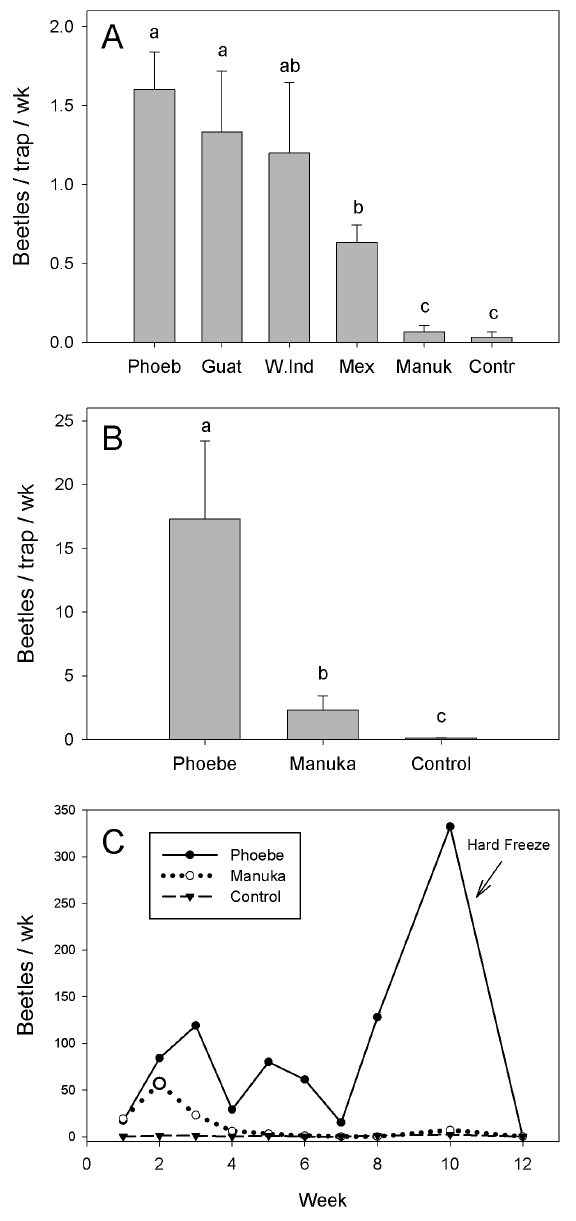
Figure 1: Captures of female Xyleborus glabratus in field trials conducted in Florida, USA. ( A ) Mean (± SE) captures in an 8-wk test (Alachua County, FL) with commercial phoebe oil lure (Phoeb), commercial manuka oil lure (Manuk), wood bolts of three cultivars of avocado: ‘Brooks Late’, Guatemalan race (Guat); ‘Simmonds’, West Indian race (W. Ind); ‘Seedless Mexican’, Mexican race (Mex), and an unbaited control (Contr); adapted from [19]. ( B ) Mean (± SE) captures and ( C ) summed weekly captures obtained in a 12-wk test (Highlands County, FL) with commercial oil lures and an unbaited control; adapted from [21]. For both tests, N = 5 traps per treatment; bars topped with the same letter are not significantly different.